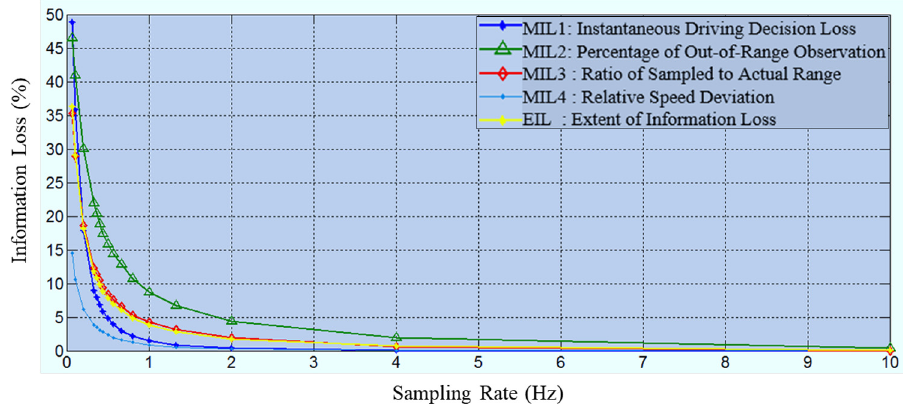
Figure 7 Extent of information loss with different sampling